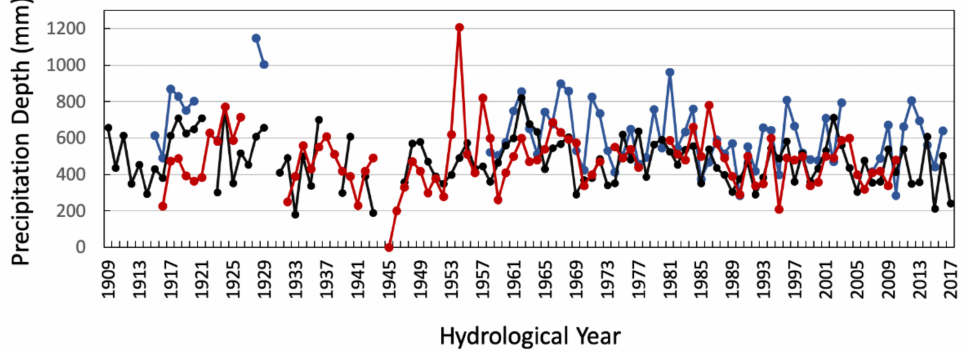
Figure 2. Measured precipitation rates in Chania (blue), Iraklion (black) and Setia (red) for one century (1909–2017) [14].